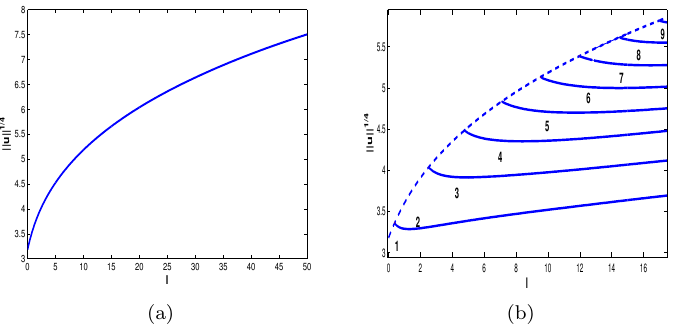
Figure 6. (a): The diagram of O (2) symmetric positive solutions by l continuation with κ = − 1 , p = 3 and λ = 1; (b): Symmetric positive solutions bifurcated from O (2) symmetric positive solution branch with κ = − 1 , p = 3 and λ =